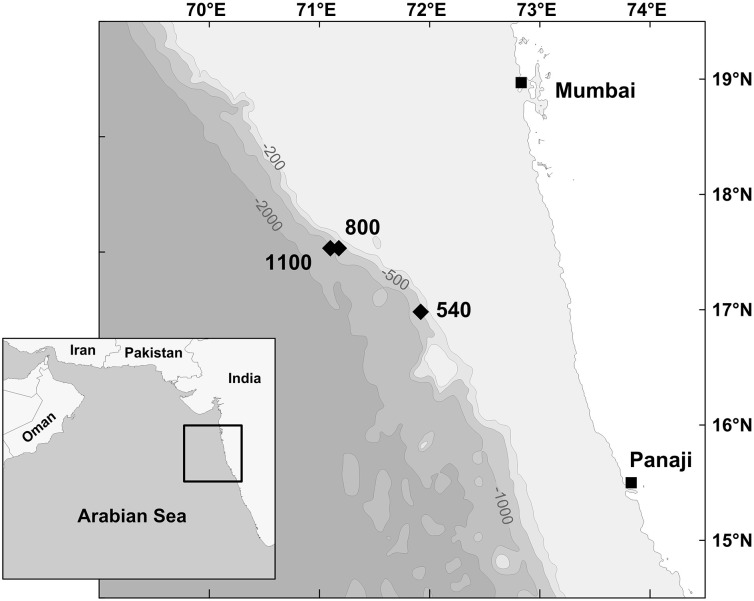
Location of the experimental sites on the Indian Margin in the Arabian Sea. Isobaths in meters.